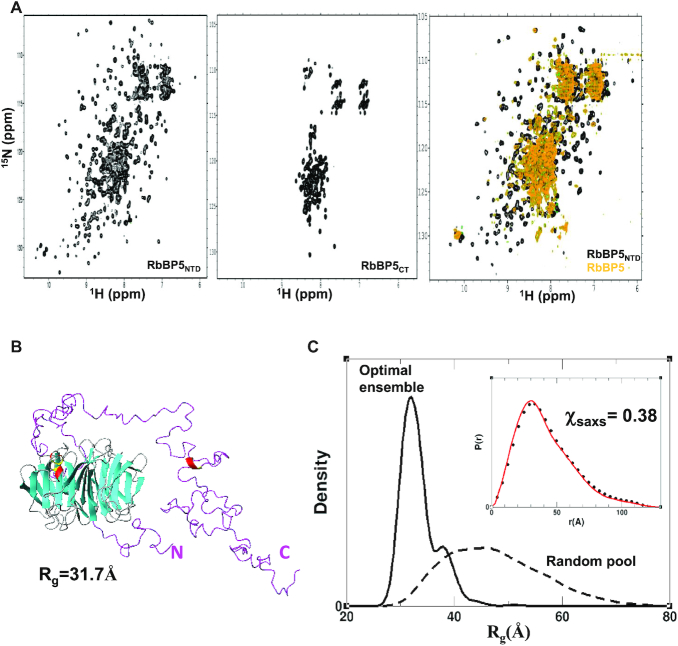
SAXS and NMR analysis of RbBP5. (A) (1H-15N)-TROSY spectra of the RbBP5NTD β-propeller domain (left), RbBP5CT (middle) and full-length RbBP5 (right). For the C-terminus (CT), the amide resonances are clustered between 7.5 and 8.5 ppm in the 1H dimension indicating that it is unfolded, while the well-dispersed spectrum of the N-terminal domain (NTD) is consistent with our homology model and the reported crystal structure (54) (PDB ID: 5OV3). Overlay of spectra of RbBP5NTD with RbBP5 (right) shows that some β-propeller resonances exhibit peak shifts. (B) A representative member of the most populated model reflects a structured NTD and a flexible, but non-random CT. (C) The clear difference in Rg distribution profiles for the initial pool of 30 000 models (with random conformations of the CT (dashed)) versus the SAXS-derived ensemble (solid) indicate that the CT, in the context of full-length RbBP5, is not randomly disordered. Inset shows the pair distance distribution function P(r) calculated for the experimental data (black circles) and for the SAXS-derived ensemble (red line).